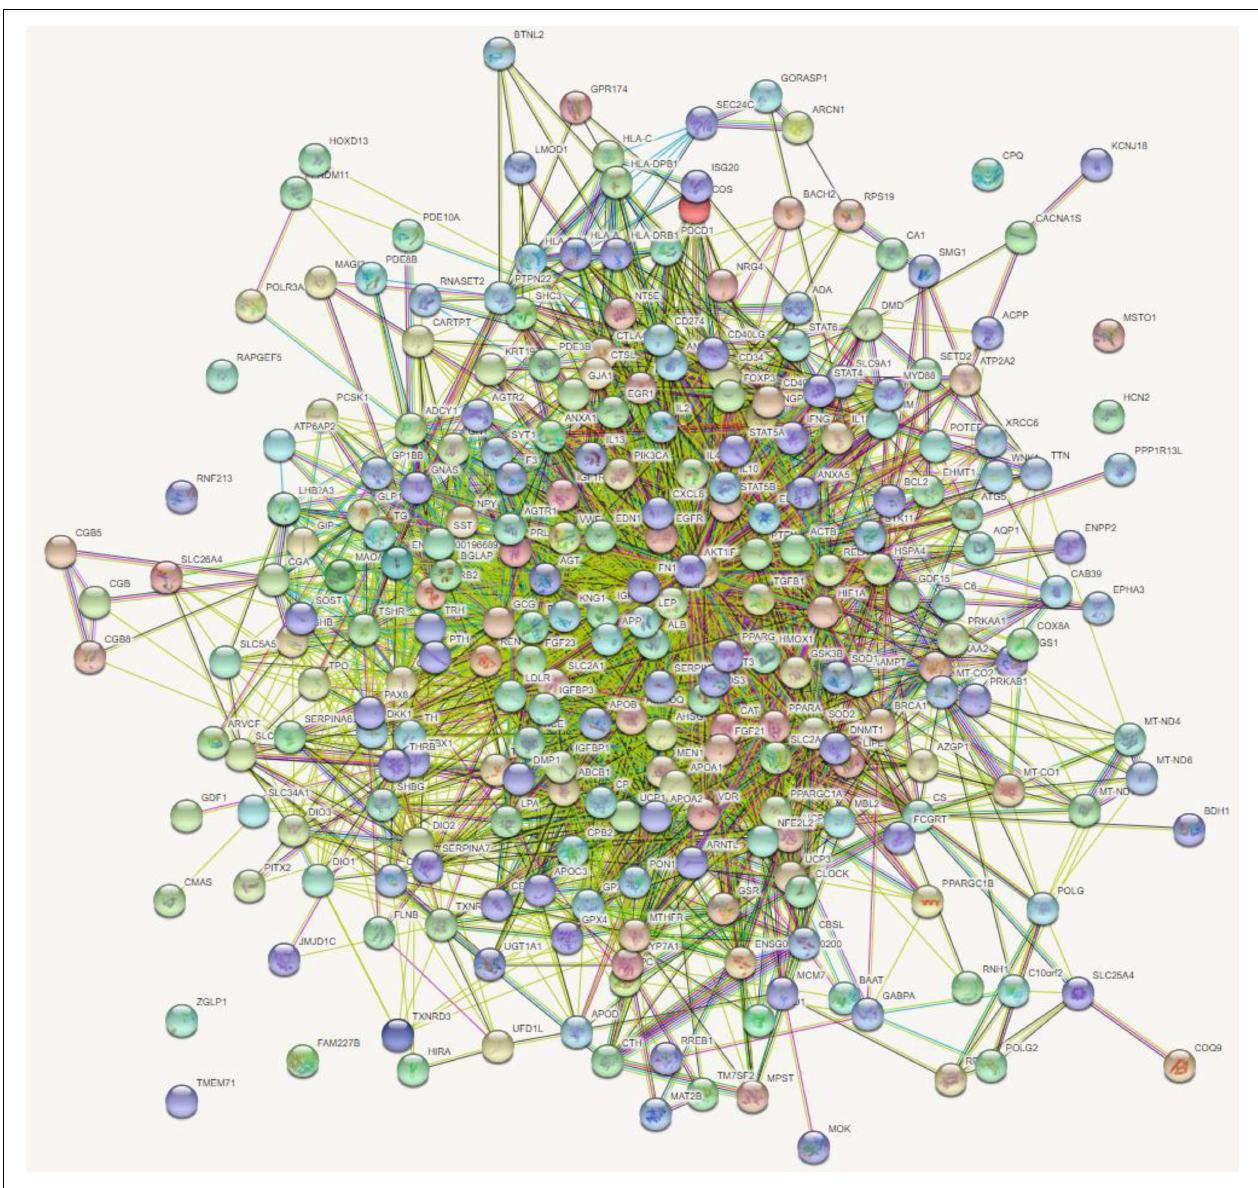
FIGURE 1 | Two hundred sixty-nine hyperthyroidism-related genes